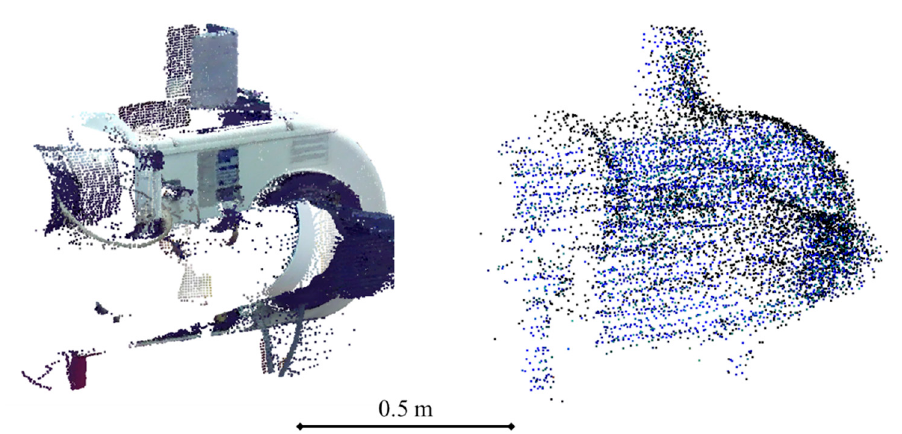
Figure 10. Example of points clouds of the cutting valve at the entrance of the water in the boilers obtained with Faro (Left) and with Zeb-Revo (Right).